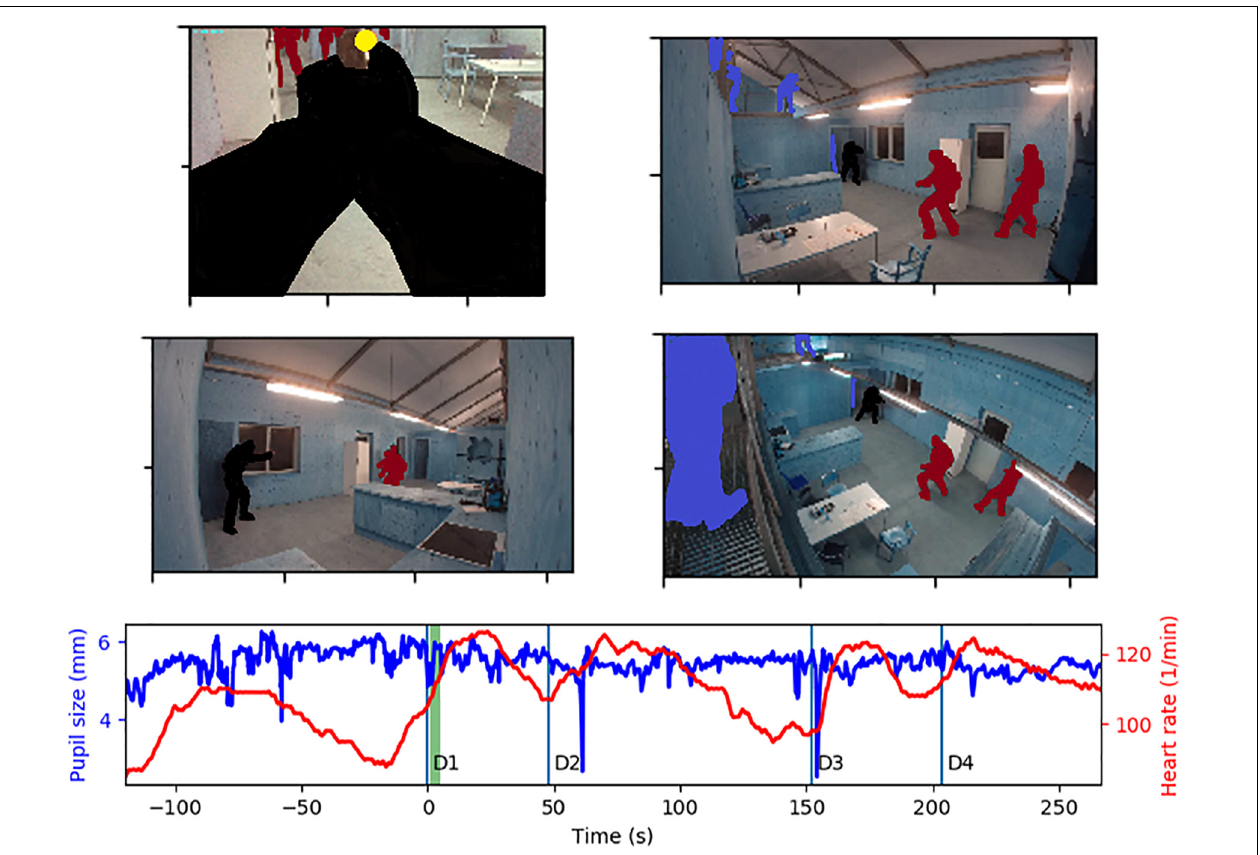
FIGURE 1 | The participant’s performance of the tasks was monitored by a forward-facing camera mounted on the SMI glasses, and three go-pro cameras mounted in the room. The study participant is marked in black, his gaze location is a yellow dot (top-left figure), the scenario figurants are marked in dark-red and the scenario instructors are marked in blue. The participant’s pupil diameter was monitored by the SMI glasses and a Bioharness equipment recorded heart rate. The period marked in green in the diagram shows from what period the images displayed originate. The onsets of task 1–4 are denoted as D1–D4 in the diagram.